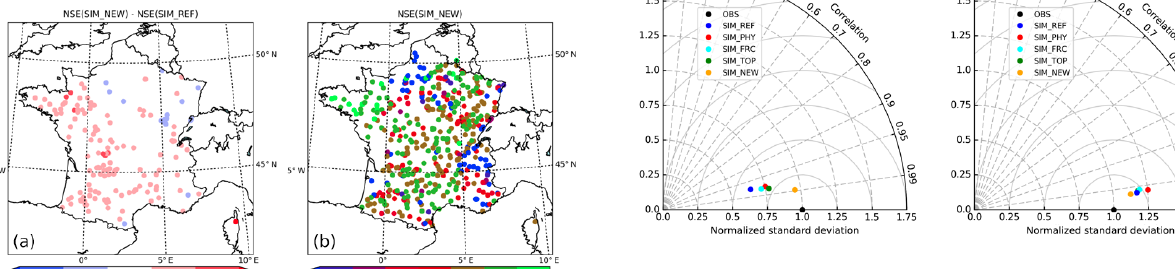
Figure 9. Taylor diagram of Q 10 and Q 90 deciles of river flows over the period